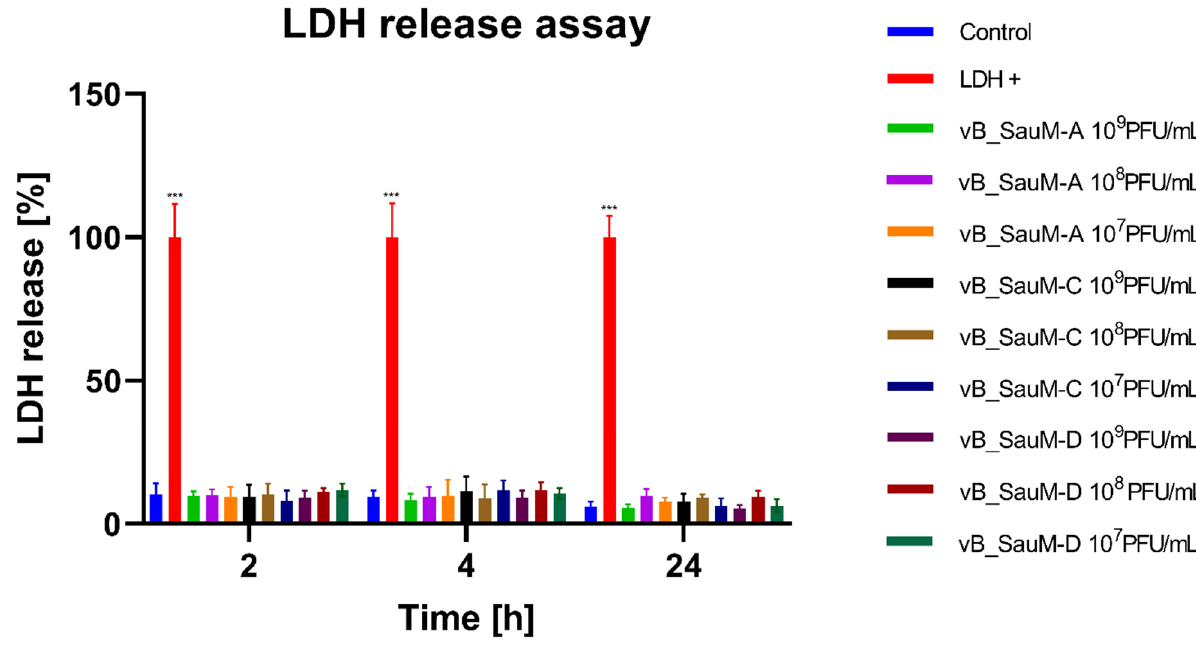
Figure 3. LDH release assay from BJ cells treated with phages vB_SauM-A, vB_SauM-C and vB_SauM-D at different concentrations after 2, 4 and 24 h of incubation in comparison to the untreated negative control (blue) and LDH release positive control (red). Mean values from three independent experiments are shown, with error bars representing SD. Statistical analysis was performed using the Kruskal–Wallis test followed by Dunn’s multiple comparison test for values with nonparametric distribution, with *** p < 0.001.